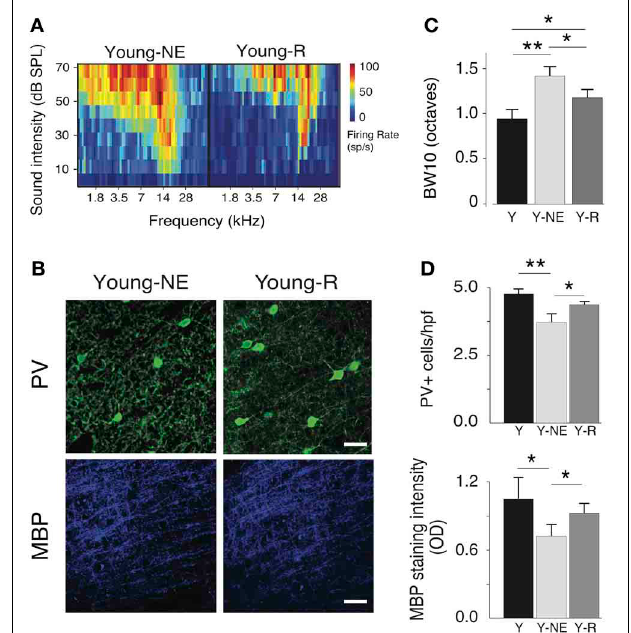
FIGURE 6 | Progressive recovery of A1 alterations after noise discontinuation. (A) Representative RFs of A1 neurons in the Y-NE and young recovered (Y-R) groups. (B) , Average BW10 in Y-NE and Y-R groups (all recorded neurons pooled). (C) , Representative high power photomicrographs showing immunoreactivity to PV and MBP in Y-NE and Y-R. (D) , Quantitative analysis of the average number of PV + cells and myelin density per high power field in all layers in the Y-R group, Y-NE and Y groups for comparison. Y: n = 6, neurons = 317; Y-NE: n = 5, neurons = 246, and Y-R: n = 4, neurons = 198. Number of hemispheres examined: Y = 8, Y-NE = 8, Y-R = 4. ∗ p < 0 . 05, ∗∗ p < 0 . 01. Scale bar: 50 µ